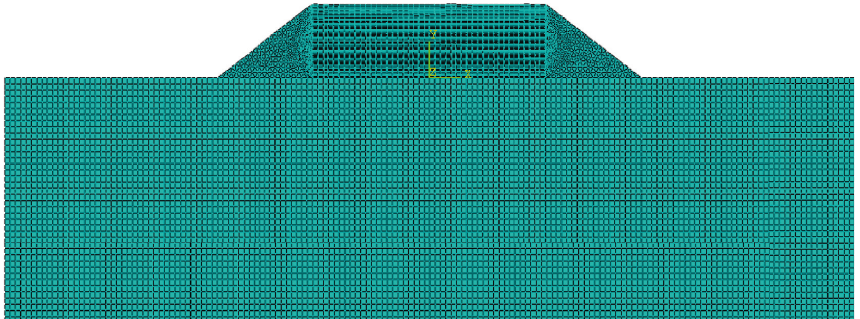
Figure 10: Meshing of the numerical